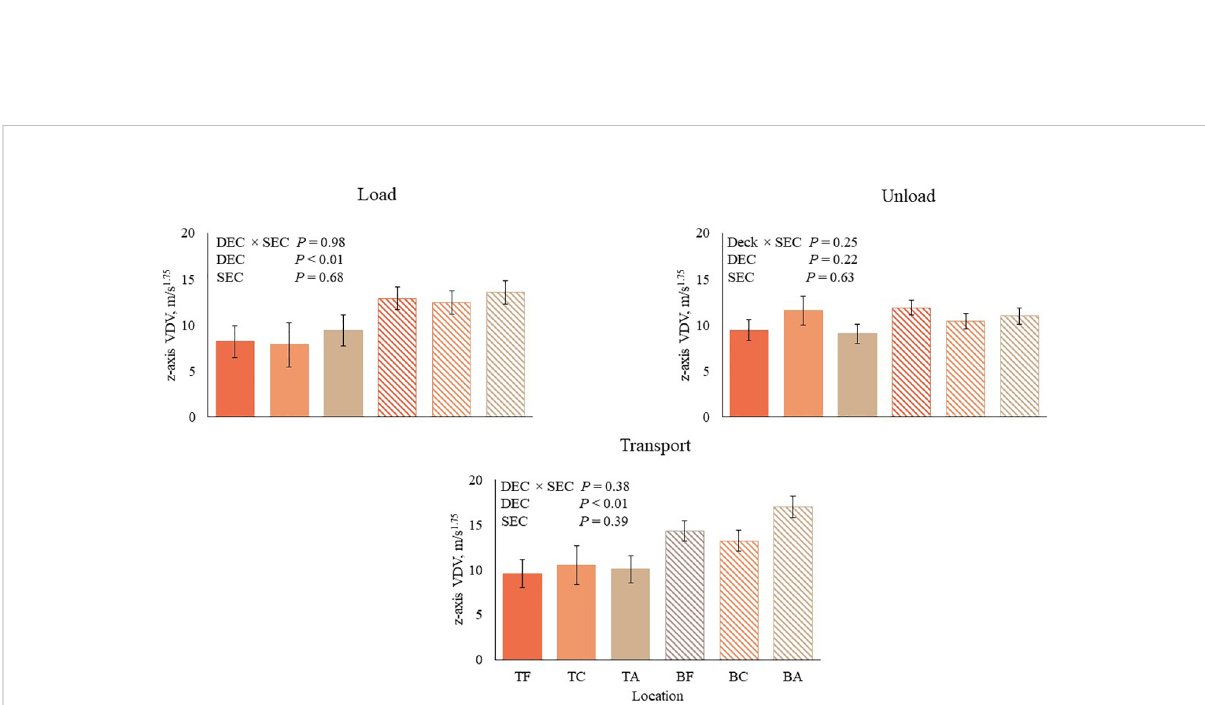
FIGURE 5 Weighted z-axis vibration dose value (VDV) experienced by pigs transported within two decks (DEC; T, Top; B, bottom) and three sections (SEC; F, fore; C, center; A, aft) located within two trailers during loading, transport, and unloading. Two trailers transported two daily market-weight pig loads over 5 consecutive